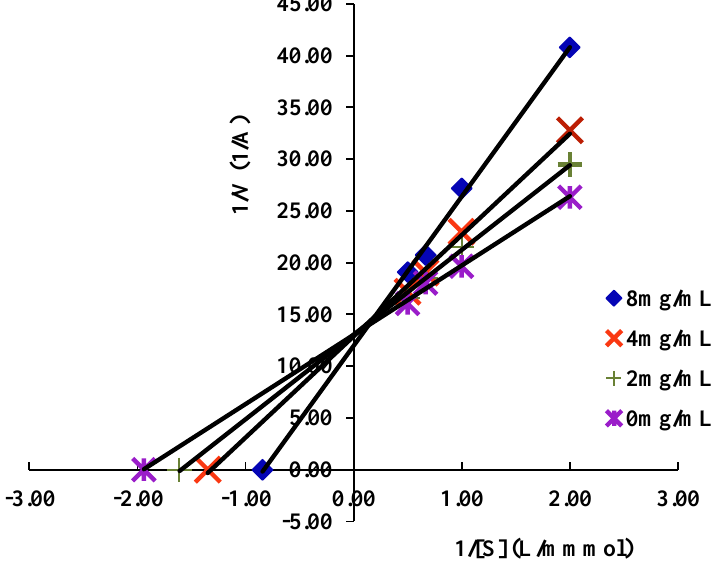
− Burk curve of MAP − 2 inhibition of α − glucosidase activity. Figure 6. Lineweaver−Burk curve of MAP−2 inhibition of α−glucosidase activity. Figure 6. Lineweaver